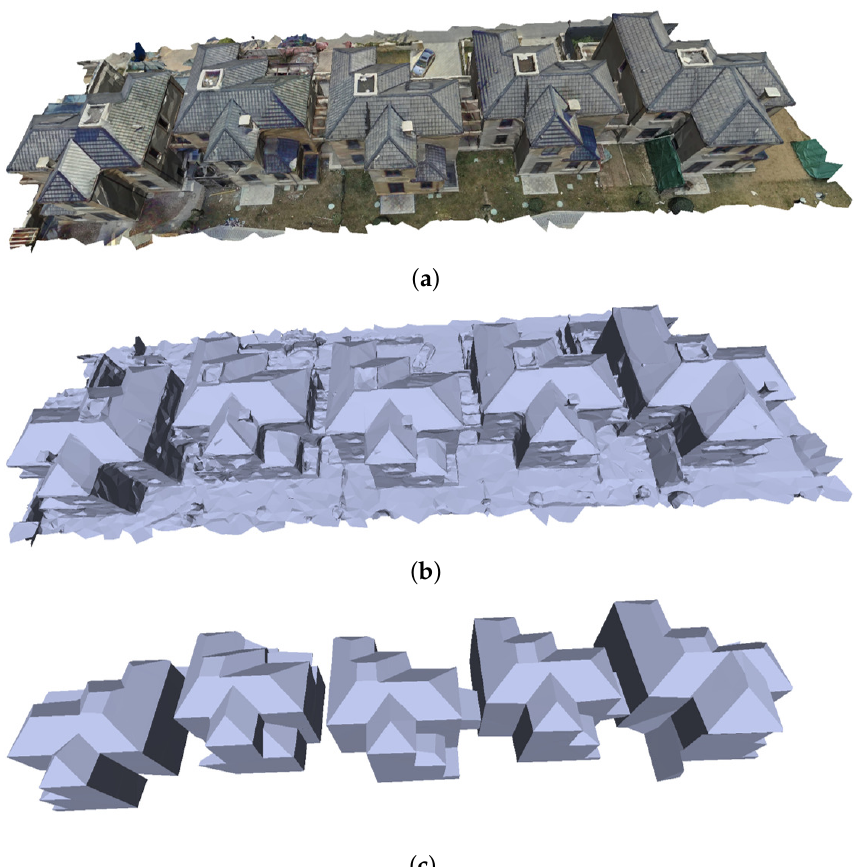
Figure 14. Application of our technique for building-mesh polygonization on Villa data: ( a ) Original with textures, ( b ) Original, and ( c ) Our building-mesh polygonization results.